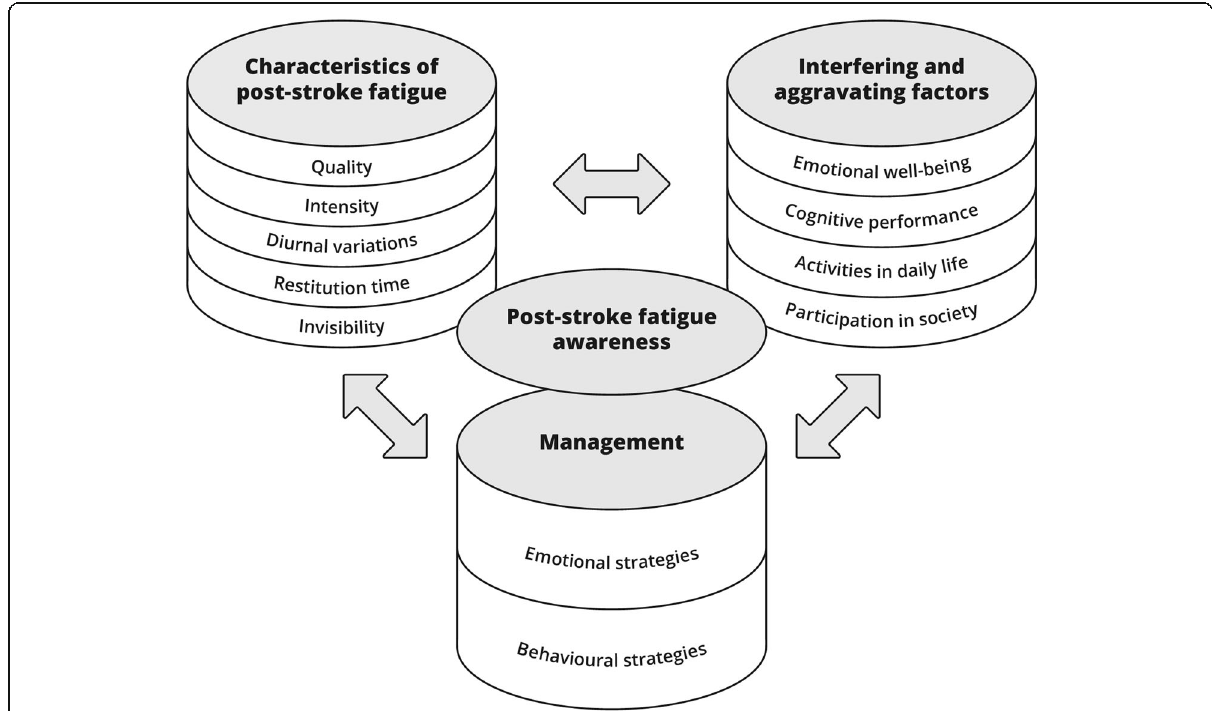
Fig. 1 Conceptual model of post-stroke fatigue, including themes and categories. PSF has different characteristics that affected how PSF interfered with patients ’ lives. These interfering and aggravating factors had to be managed, and the use of management strategies could again influence the characteristics of PSF and whether or how PSF continued to interfere with their lives. Fatigue was initially interpreted as a normal reaction to having a stroke, and stroke survivors first became aware of PSF sometime after their initial hospital